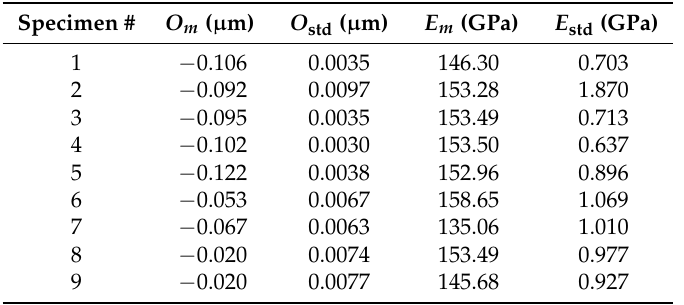
Table 3. Specimen-dependent estimated values of mode and standard deviation of the unknown model parameters O and E